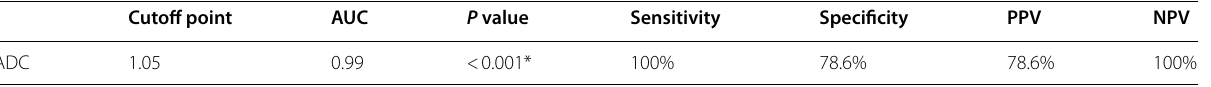
*indicates statistically significant value Table 6 Cutoff value, sensitivity and specificity of ADC as a predictor of high grade neoplastic lesions